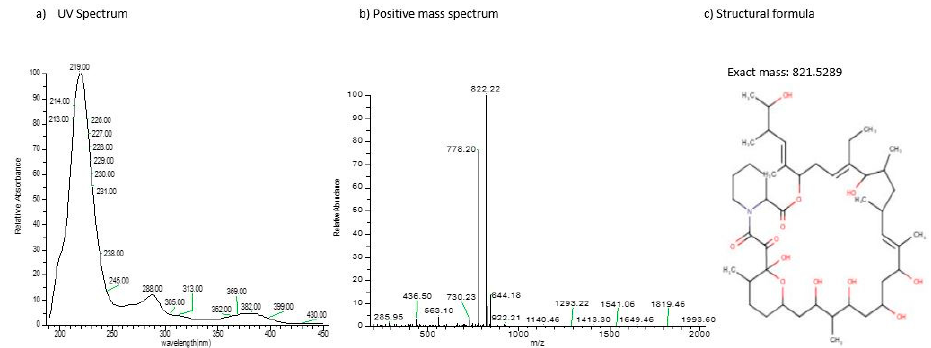
Figure 5. Characteristics of meridamycin, a metabolite observed from isolate BR123, calculated using HPLC-MS analysis. ( a ) The UV-visible spectrum; ( b ) the positive ion mass spectrum; and ( c ) the structural formula.